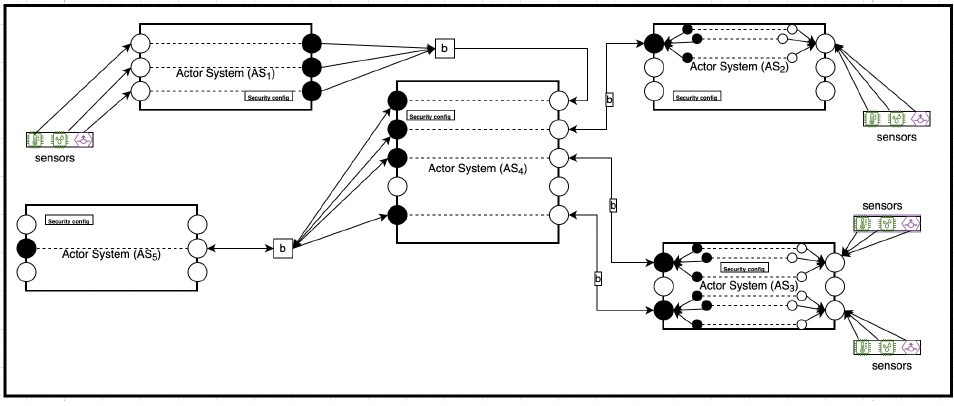
Figure 1. Secure Communication between IoT